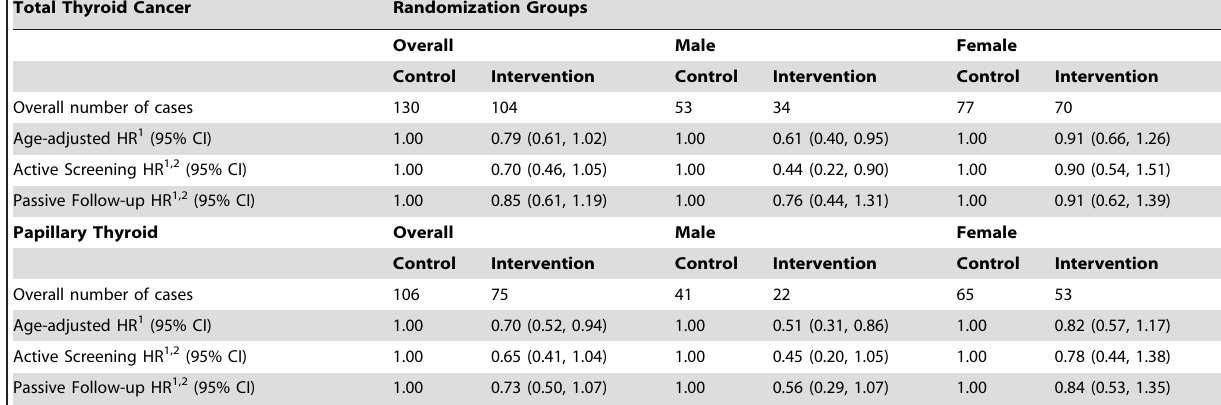
National Lung Screening Trial (NLST) Total Thyroid